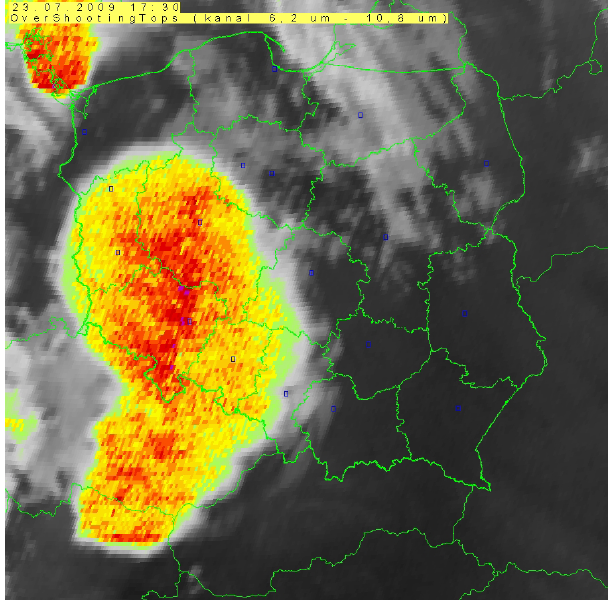
Figure 1. Satellite WV–IR (water vapour–infrared) OSTs (over- shooting tops) product at 17:30UTC on 23 July